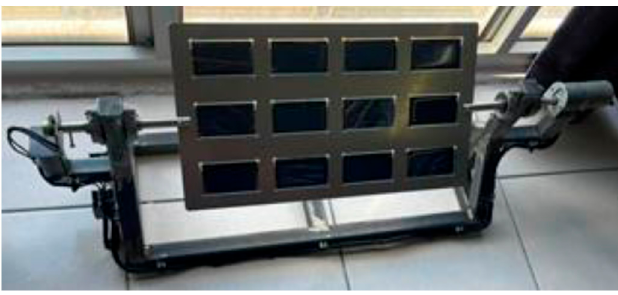
Figure 1. Final modular monitoring system.